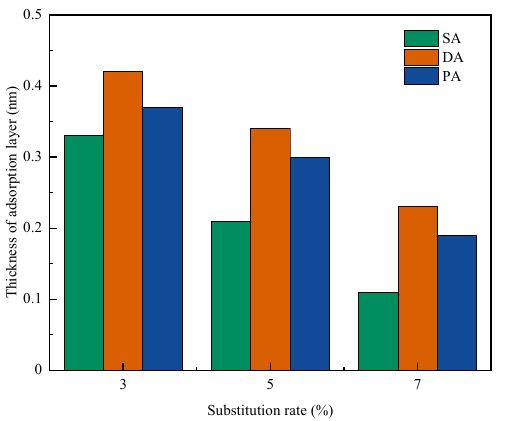
Figure 6. Effect of different separate addition methods on the thickness of adsorption layer of PCE in cement with Na ‐ Mmt .